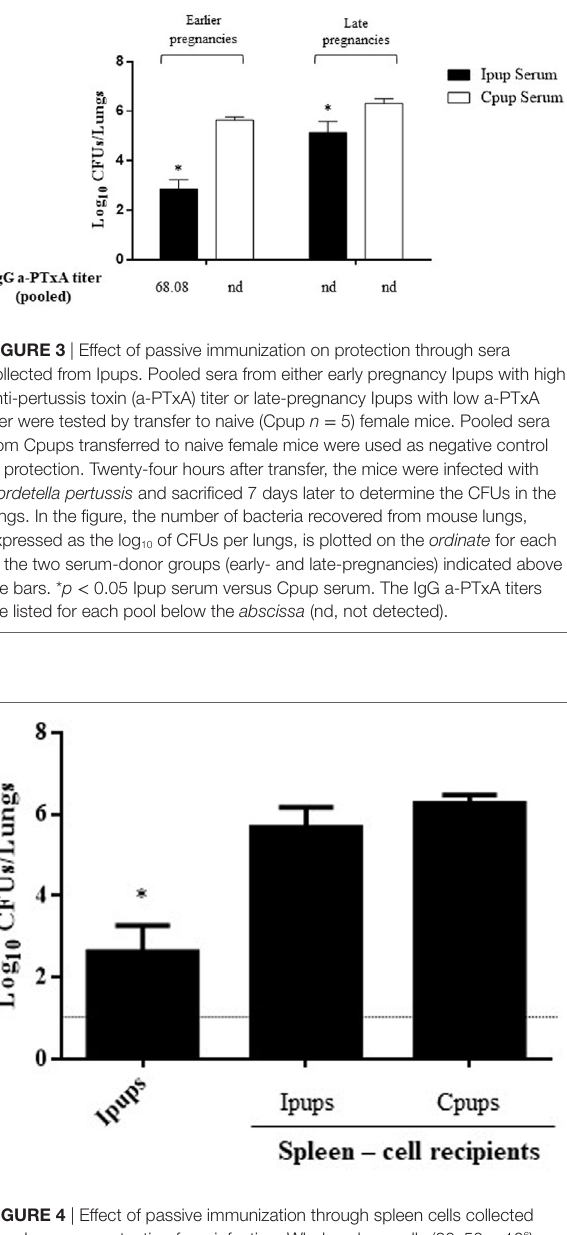
FigUre 4 | Effect of passive immunization through spleen cells collected from Ipups on protection from infection. Whole spleen cells (20–50 × 10 6 ) from Ipups or Cpups (controls) were tested as possible vehicles of immune protection by passive transfer to naïve mice. Twenty-four hours after transfer, the mice were infected with Bordetella pertussis and sacrificed 7 days later to determine the CFUs in the lungs. Ipup-recipients were used as a positive control. In the figure, the number of bacteria recovered from the mouse lungs, expressed as the log 10 (mean CFUs ± SD of per lungs), is plotted on the ordinate for each of the spleen-cell-recipient groups ( n = 7) indicated on the abscissa . The dotted horizontal line marks the lower limit of detection. * p < 0.05 Ipups versus both spleen-cell recipient groups.